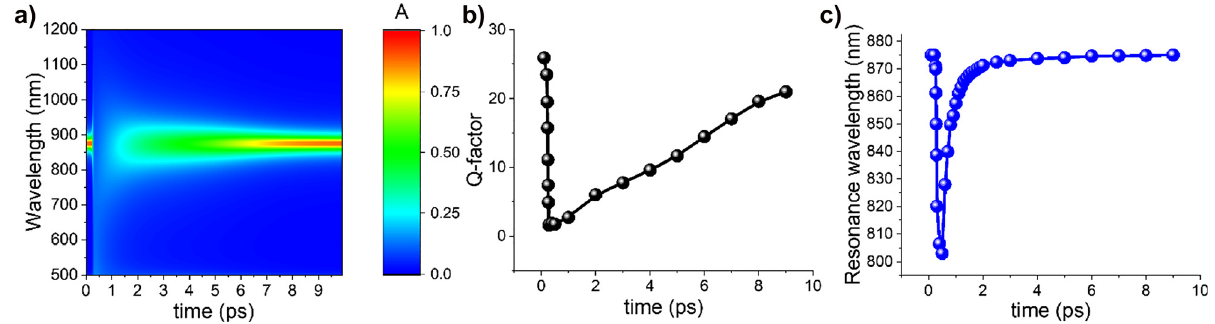
Figure7: Tunabilityofresonancesinthegap-plasmonmetasurface.(a)Tunableultrafasttransientabsorptionasafunctionofwavelengthand time. (b) The computed Q -factor of the absorption resonance response varying in time. (c) The tunable absorption resonance wavelength is shifted as a function of